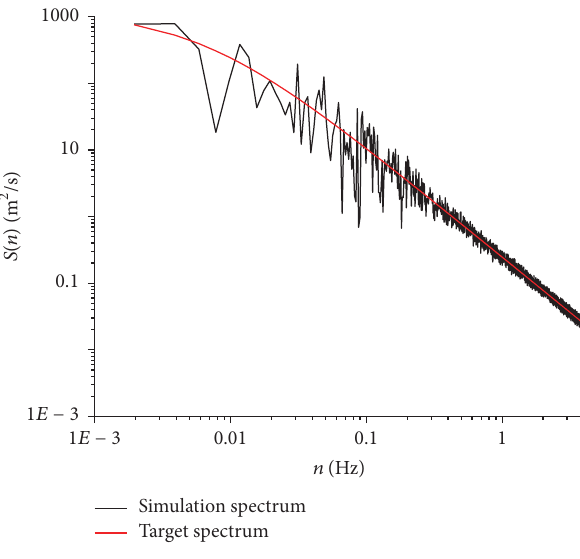
Figure 4: Wind speed